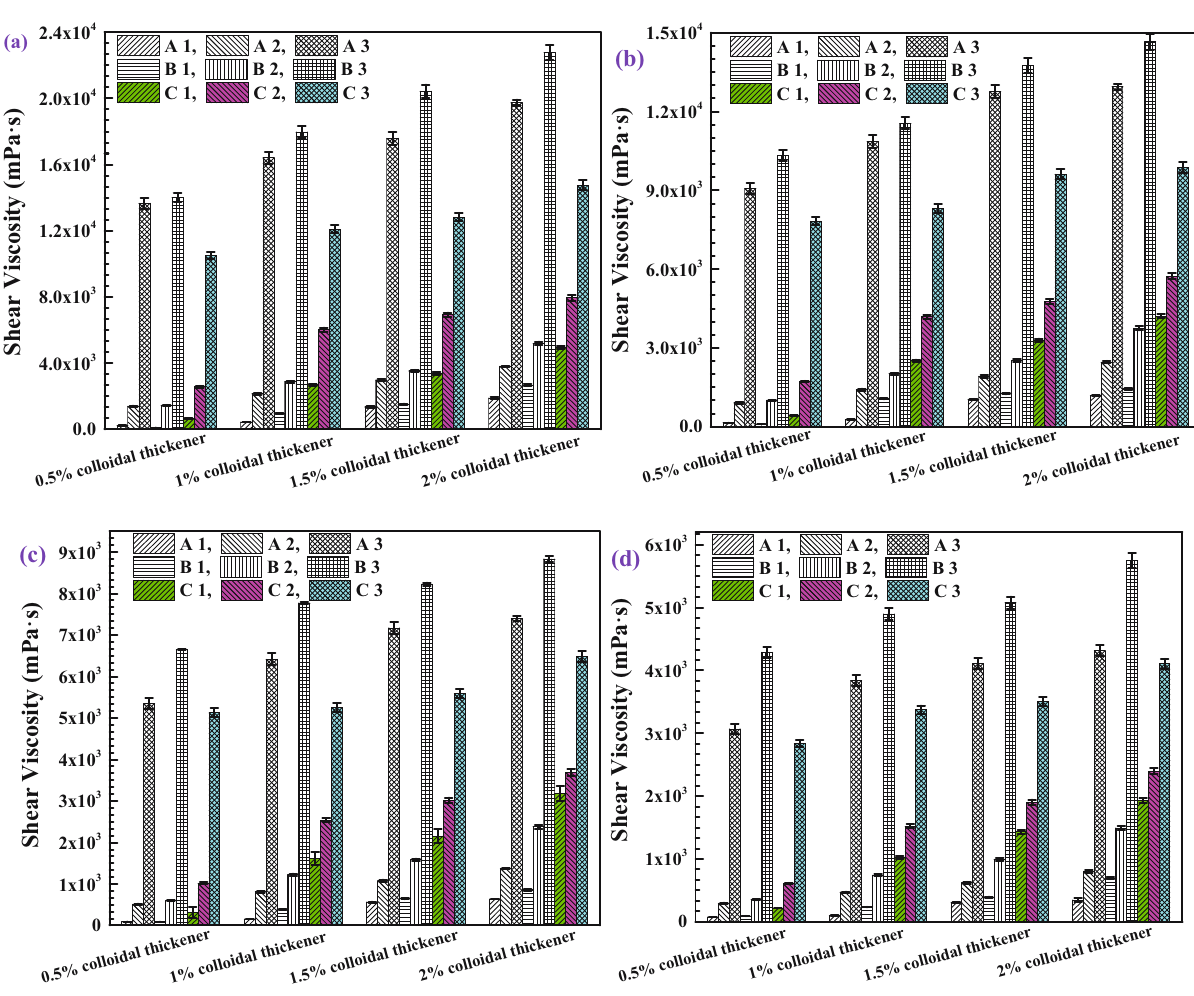
Figure 5: Relationship between shear viscosity and thickener concentration at room temperature: ( a ) the shear rate is 6 s −1 , ( b ) the shear rate is 10 s −1 , ( c ) the shear rate is 20 s −1 , ( d ) the shear rate is 40 s −1 , A1: XG + DIW, A2: XG + BJ, A3: XG + NLRS, B1: GG + DIW, B2: GG + BJ, B3: GG + NLRS, C1: TBG + DIW, C2: TBG + BJ, C3: TBG +